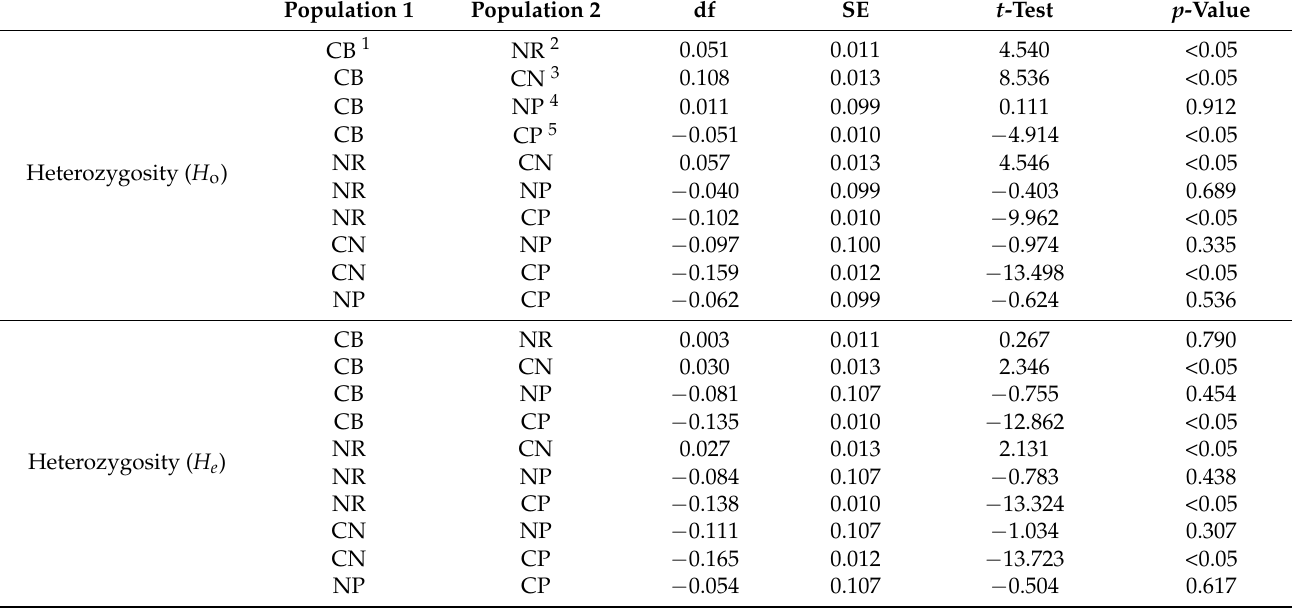
Table 3. Comparison of genetic diversity parameters between Siamese ( Crocodylus siamensis , Schnei- der, 1801) [1] and saltwater crocodiles ( Crocodylus porosus , Schneider, 1801) [13] based on 22 microsatel- lite loci. Table S1 provides detailed information on the sampled individuals.